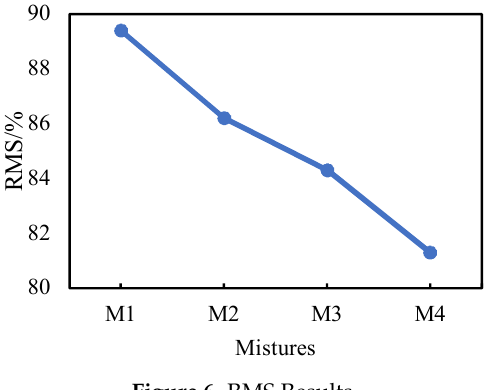
Figure 6. RMS Figure 6. RMS Results.